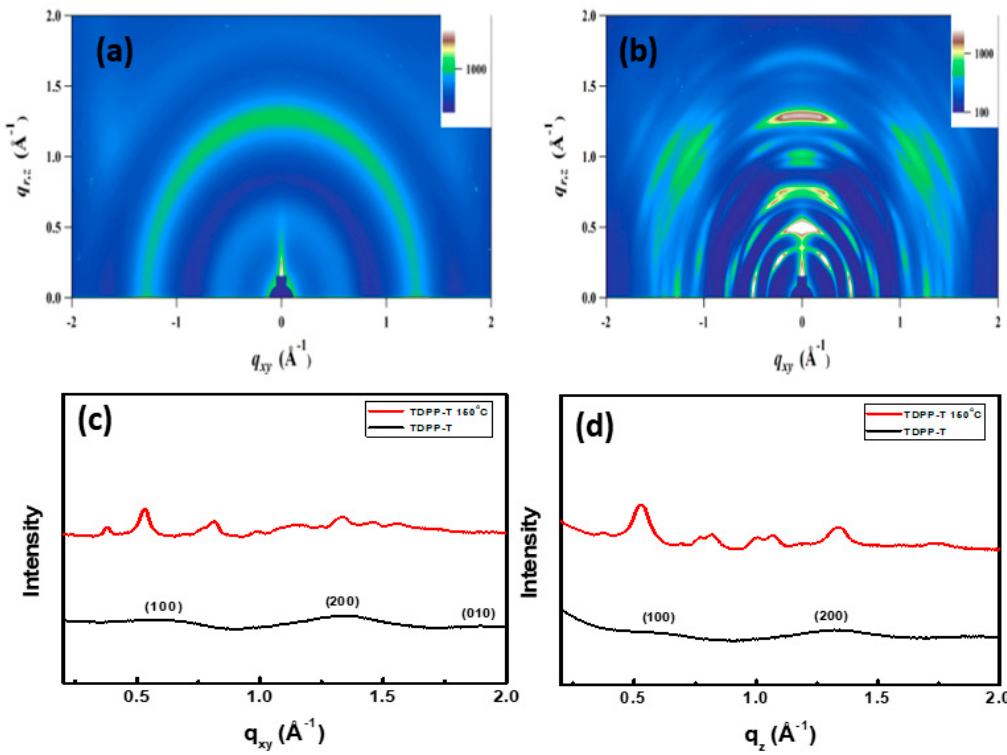
Figure 5. Two-dimensional grazing incidence X-ray diffraction images of TDPP-T ( a ) without annealing and ( b ) with being annealed at 150 °C, corresponding line-cuts along the ( c ) q xy and ( d ) q z plane.